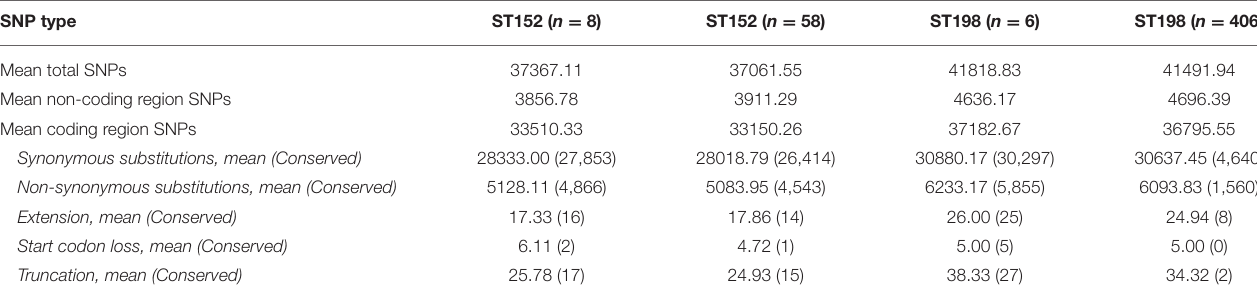
TABLE 2 | Mean number of single nucleotide polymorphisms (SNPs) identified in the subset and a total study population of S. Kentucky ST152 sequences mapped to the ST198 reference strain PU131, and S. Kentucky ST198 sequences mapped to the ST152 reference strain